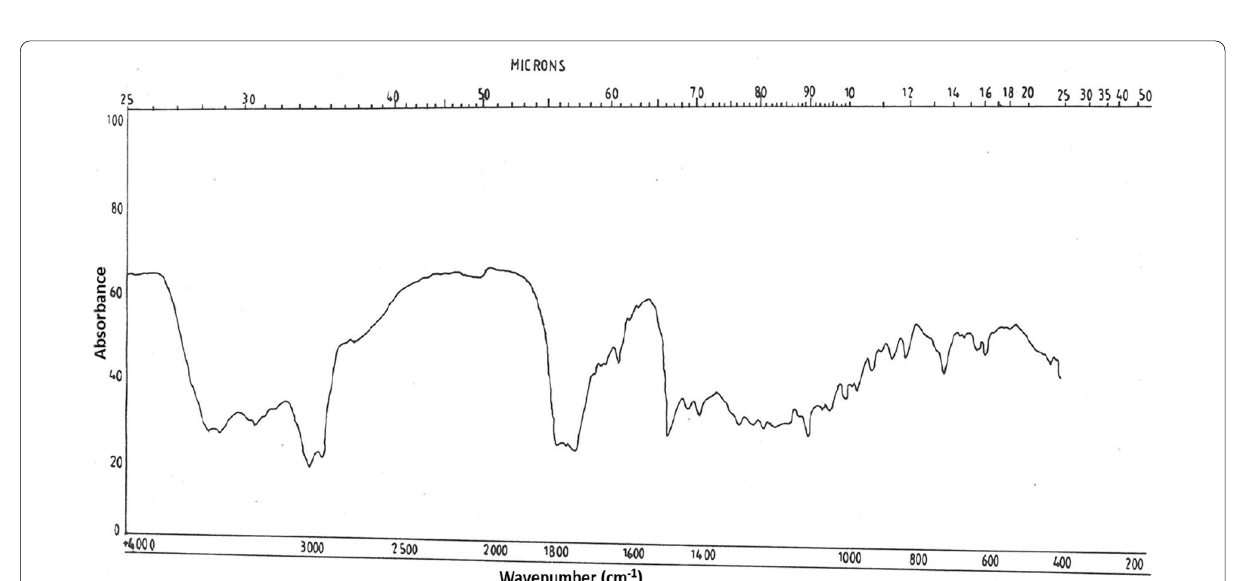
Fig. 4 Infrared spectrum of antifungal compound (dihydroxyanthraquinone) from C.